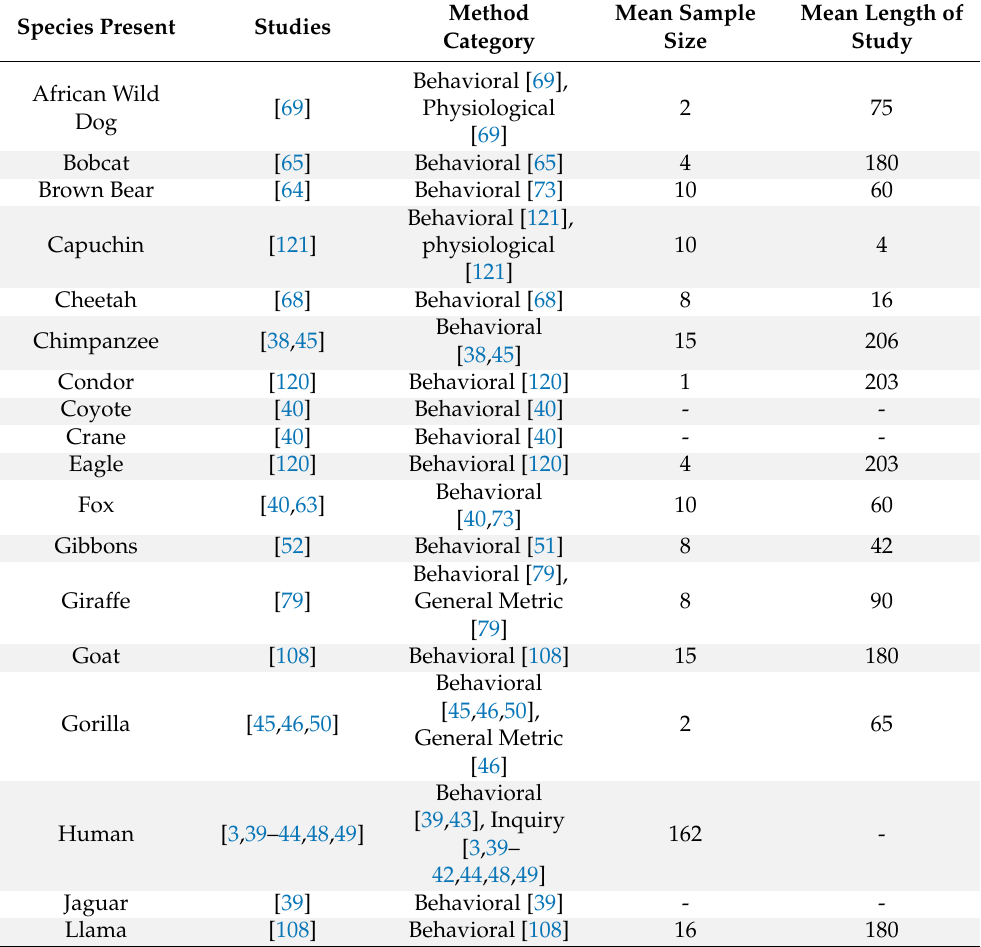
Table 3. Overview of zoo animal inclusion. The mean study length column represents the average time (in days) of study procedures. Shading added to aid